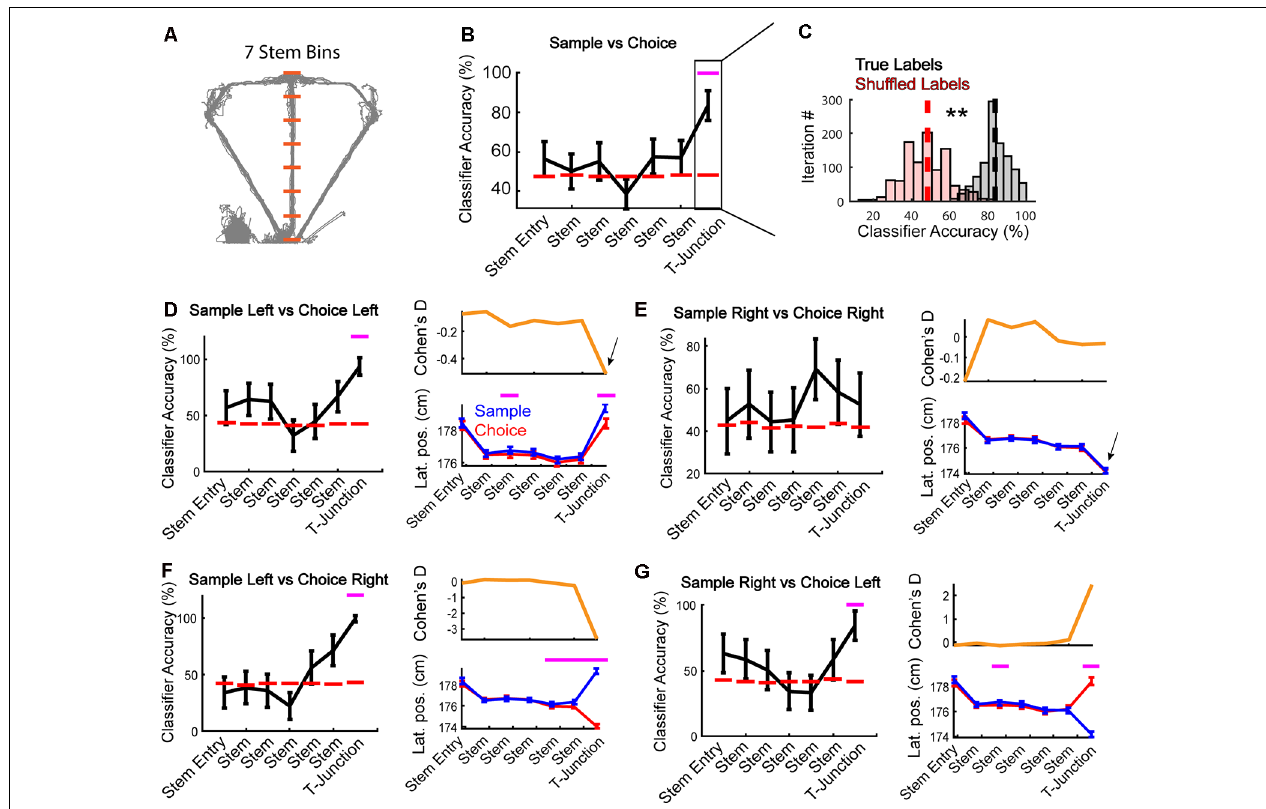
FIGURE 2 | Apparent encoding of task phase is supported by representations of trajectory-dependent behaviors. (A) Depiction of stem bins superimposed on position data from an example session (space between orange dashes) used in the following analyses. Orange lines highlight the start/endpoints for spatial bins on the maze used in panel (B) . The 7th bin from the start of the stem was defined as a T-junction (see “Results” section). (B) A linear classifier was trained to predict the task phase (sample vs. choice) across all stem bins ( N = 187 neurons per bin). Notice that task phase is accurately predicted at T-junction (7th bin/T-junction: Z = 3.1, p = 0.002 z -test against shuffled distribution). Data are represented as mean ± standard deviation of 1,000 classifications. Magenta dashes indicate a p -value < 0.05. (C) A demonstration from the T-junction of how our classification averages were obtained (see “Materials and Methods” section). A z -test was then performed using the mean classification accuracy on true labels, against a shuffled distribution. Dashed lines indicate the average classification accuracy across iterations. **Indicates p < 0.01. Statistics are identical to that in panel (B) . (D) Left panel: the mPFC was trained to predict whether rats were on a sample or choice phase during left trajectory runs. The classifier could accurately predict task phase at T-junction ( Z = 2.9, p = 0.004). Right panel: session averaged lateral position (“Lat. pos”) data revealed that rats lateral position at early stem and T-junction varied with task phase (main effect of task phase F (1,6) = 4.75, p = 0.03; bin 3: t (43) = − 3.5, p = 0.001; bin 7: t (43) = − 5.1, p = 7.8e-06). (E) The mPFC was trained to predict task phase from right trajectory runs. Notice that at T-junction, the classifier did not significantly predict task phase ( Z = 0.57, p = 0.572). Right panel: there was no main effect of task phase ( F (1,6) = 0.08, p = 0.7), or task phase × bin interaction ( F (1,6) = 0.31, p = 0.9). (F) A right turn on choice phase always followed a left turn on the sample phase in the included data (only correct trials were included). The mPFC only predicts left samples/right choices at T-junction ( Z = 3.0, p = 0.002), the location where lateral position (right panel) differs. There was an interaction between task phase and bin ( F (1,6) = 41.98, p = 5.7e-43). Paired t -tests revealed significant difference in lateral position based on task phase—trajectory combination (bin 5: t (44) = − 3.1, p = 0.003, bin 6: t (44) = − 4.2, p = 0.0001, bin 7: t (44) = − 36.9, p = 9.3e-35). (G) Choice lefts always followed sample rights in the included data (correct trials). We found that sample right and choice left neuronal activity was functionally distinct at T-junction ( Z = 2.5, p = 0.014). This effect coincided with changes in the rat’s lateral position ( F (6) = 26.1, p = 1.22e-27 interaction between the task phase and bin). Classification data are represented as mean ± standard deviation with magenta lines indicating p < 0.05 from a z -test. Behavioral data are represented as mean ± SEM with magenta lines indicating p < 0.007 from a t -test with a Bonferroni corrected alpha of